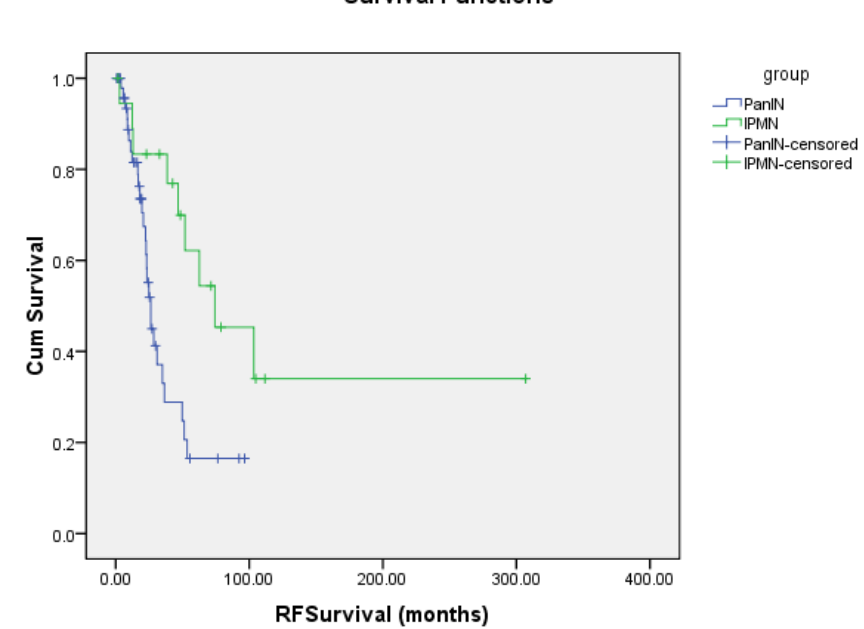
Figure 2. Progression free survival of PanIN and IPMN. RFSurvival — Progression Free Survival